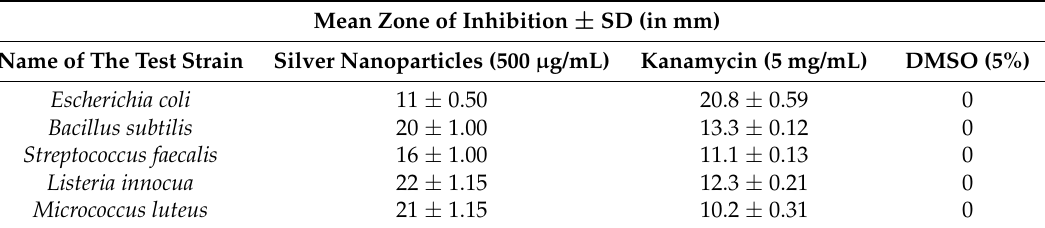
Table 3. Antimicrobial activity of AgNPs by agar-well diffusion method.